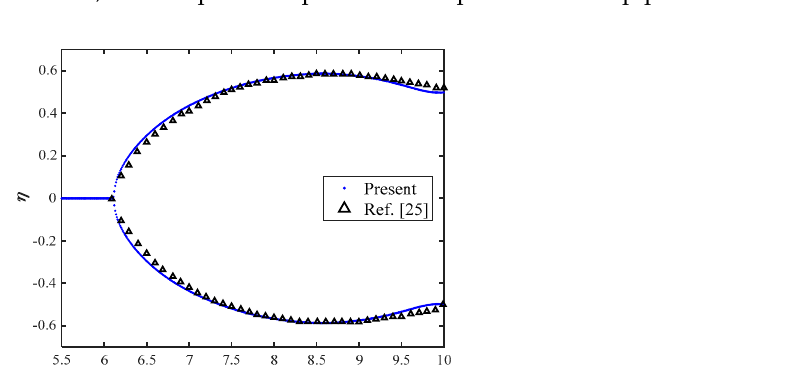
Figure 2. Bifurcation diagrams for the tip − end responses of a pipe system without dry friction, for α = 0, β = 0.142, and γ = 18.9.